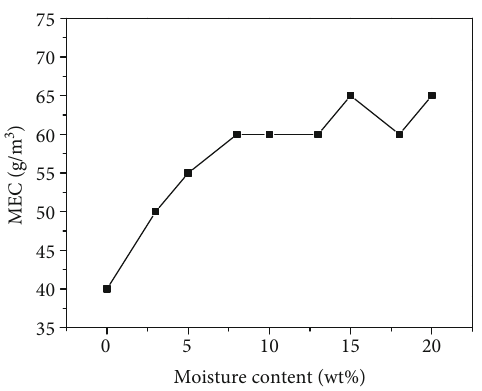
Figure 6: Variation of the minimum explosible concentration of aluminum powder with moisture